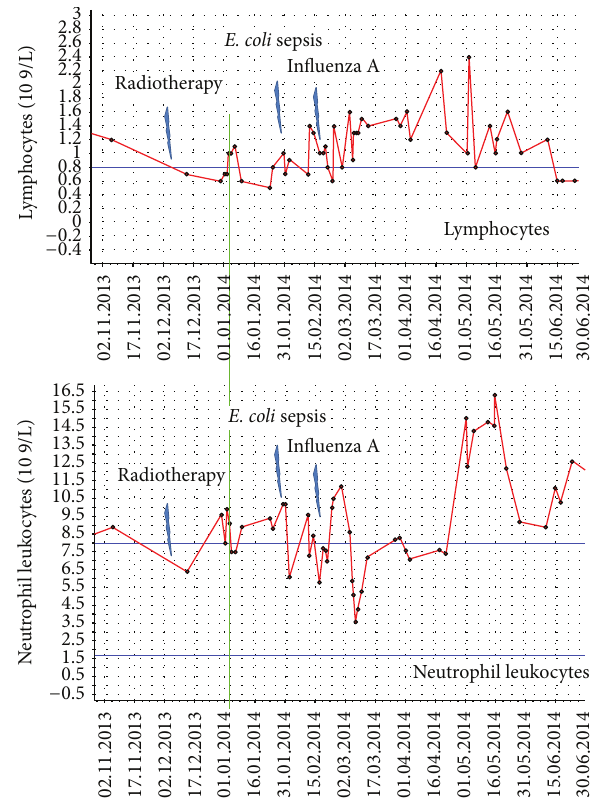
Figure 6: Computed tomography scan of the thorax showing progression of the right-sided pulmonary metastases approximately 3monthsafterradiotherapytoothertargets.Temporarynontargeted